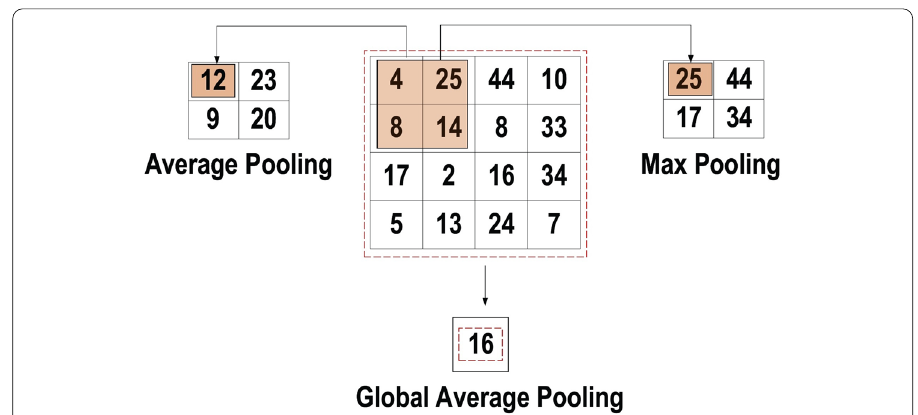
Fig. 9 Three types of pooling